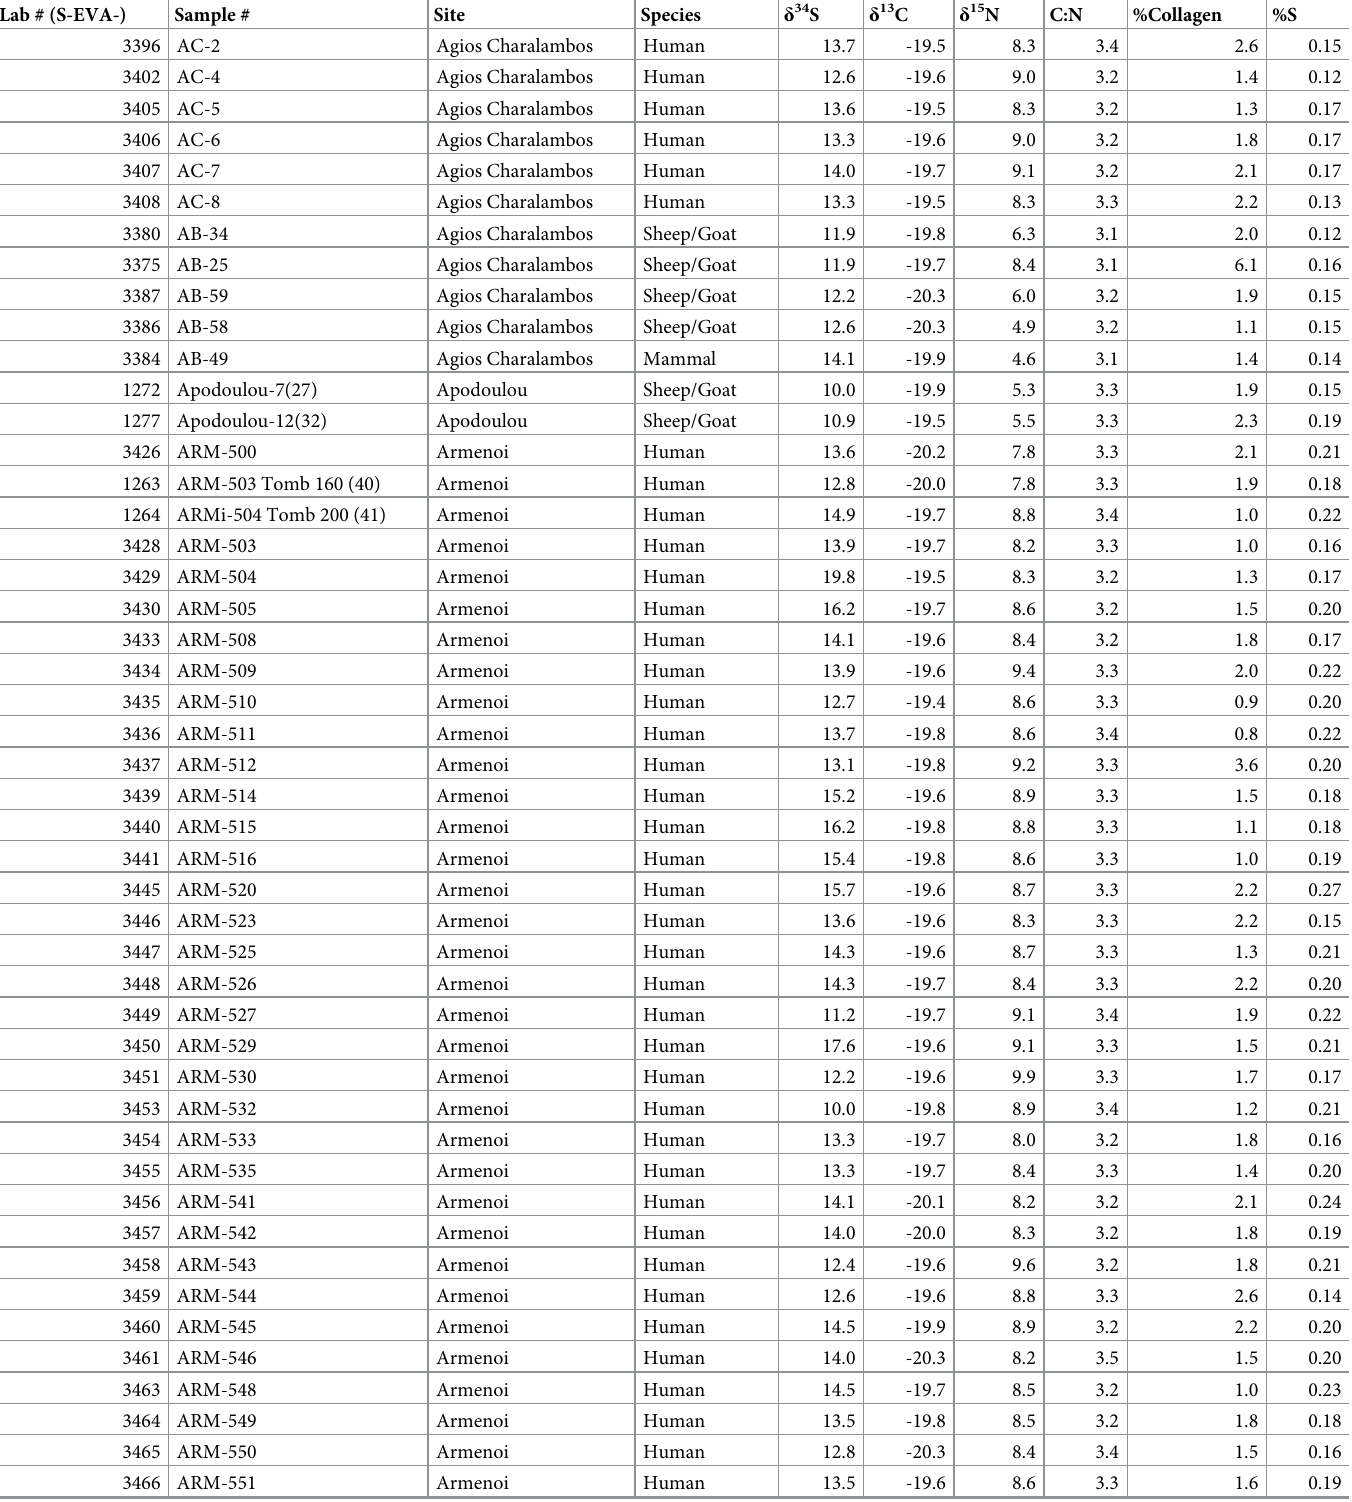
Table 4. Table of the sulphur isotope values of humans and fauna from the study sites. Also included are bone collagen carbon and nitrogen isotope values. Lab #